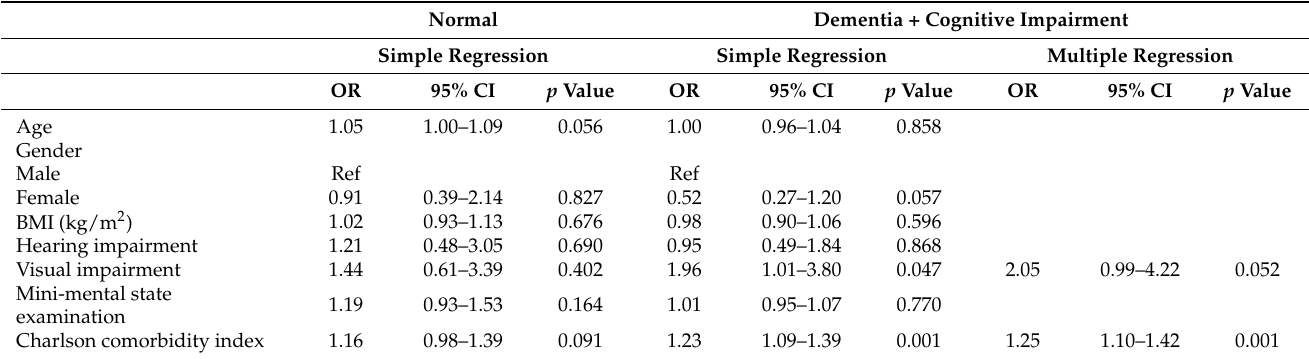
Table 5. Associated Factors of Readmission within 30